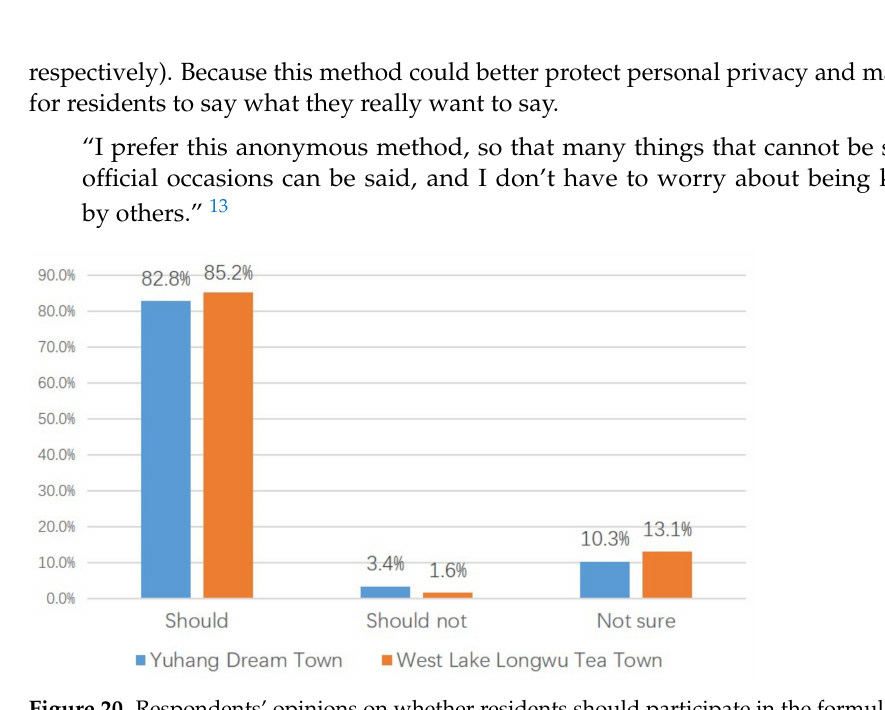
Figure 20. Respondents’ opinions on whether residents should participate in the formulation process of the planning and construction of the local CT practice (source: authors).